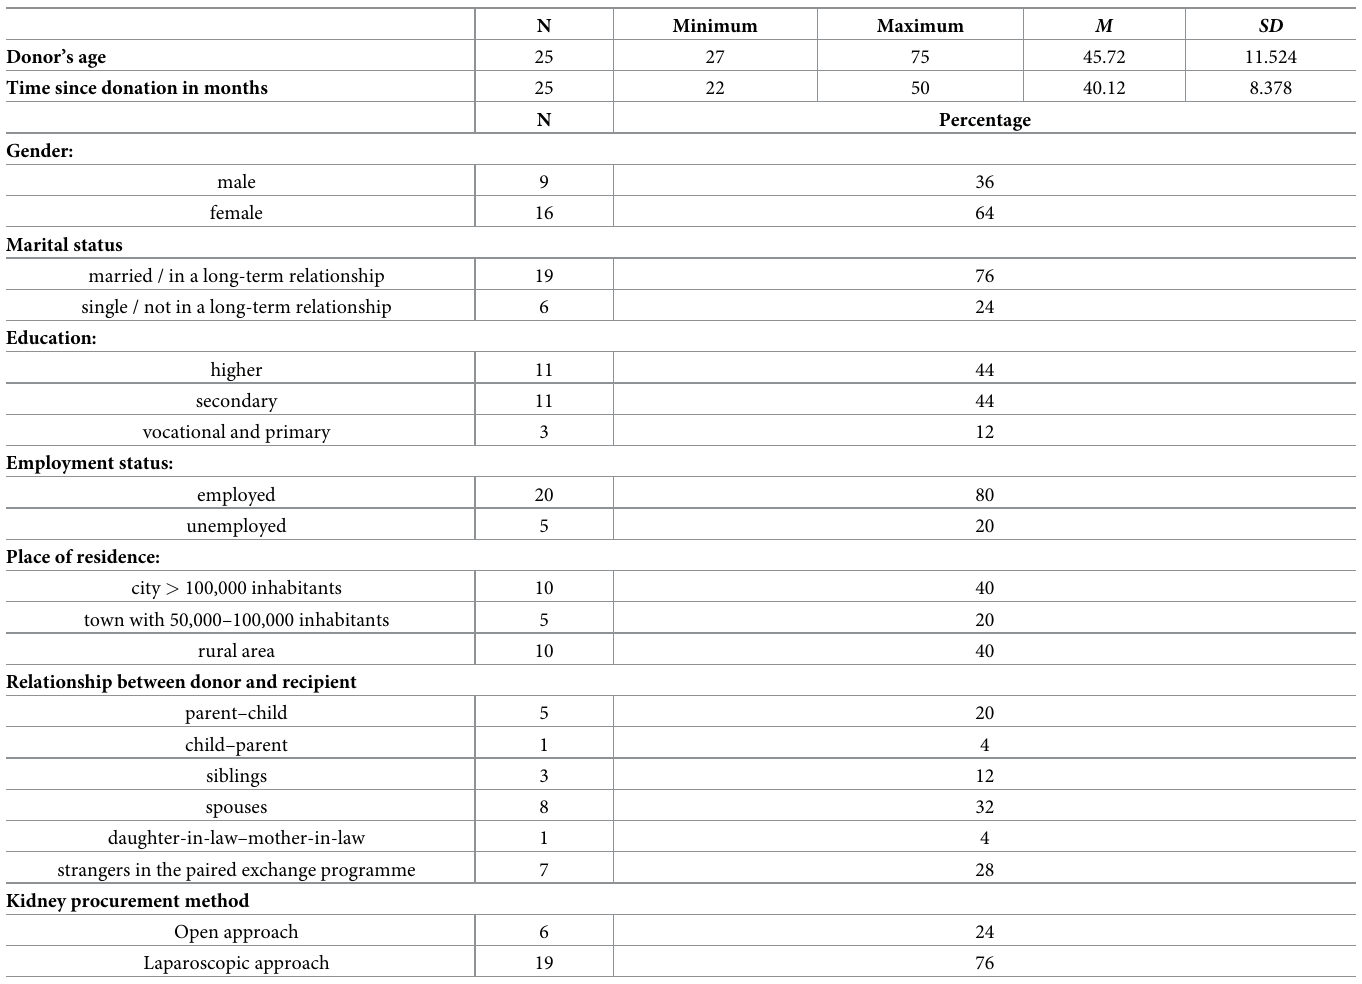
Table 1. Sample socio-demographic